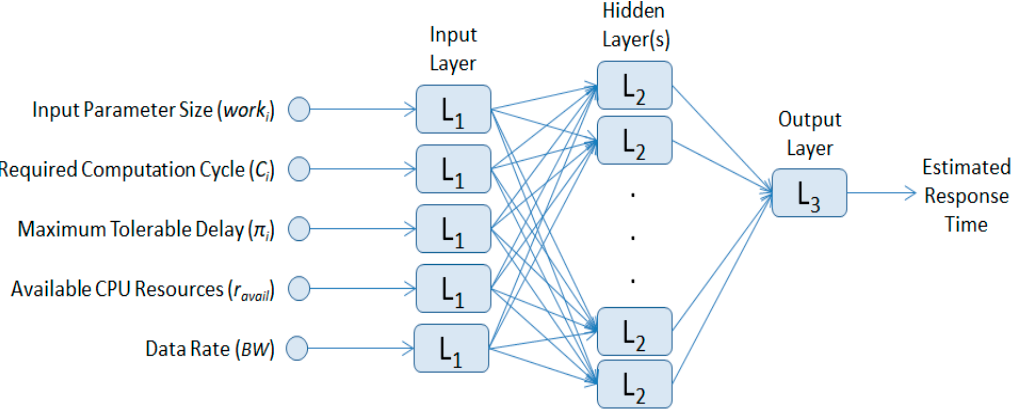
Figure 4. ANN-based response time prediction module.